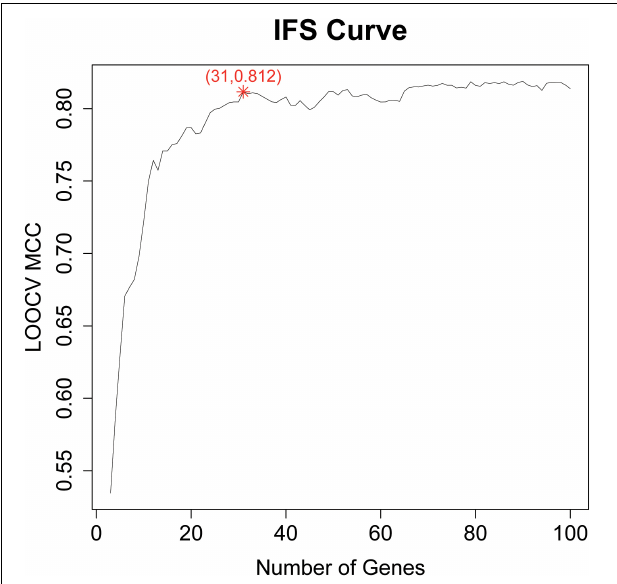
FIGURE 1 | The IFS curve of the top 100 mRMR genes. The x -axis was the number of genes and the y -axis was the prediction performance, i.e., LOOCV MCC. The peak MCC was 0.812 when 31 genes were used. These 31 genes were selected as optimal GBM biomarker genes.